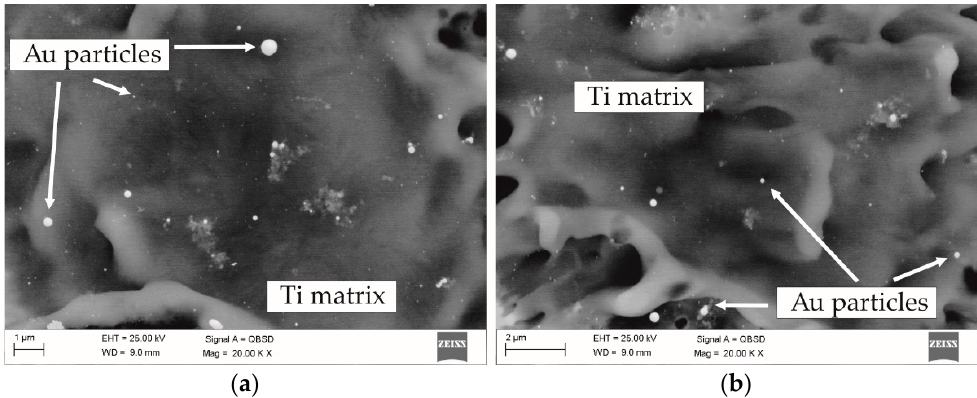
Figure 8. Gold particles in center of the laser irradiation area: ( a ) laser power 22 mW; ( b ) laser power 17.6 mW.